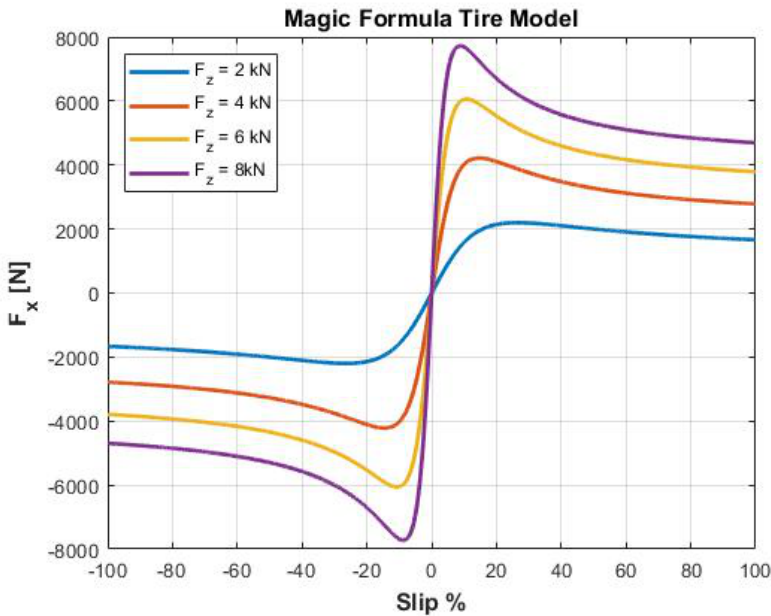
Figure 3. Generic tire longitudinal slip ratio vs. longitudinal force for different normal tire force cases.